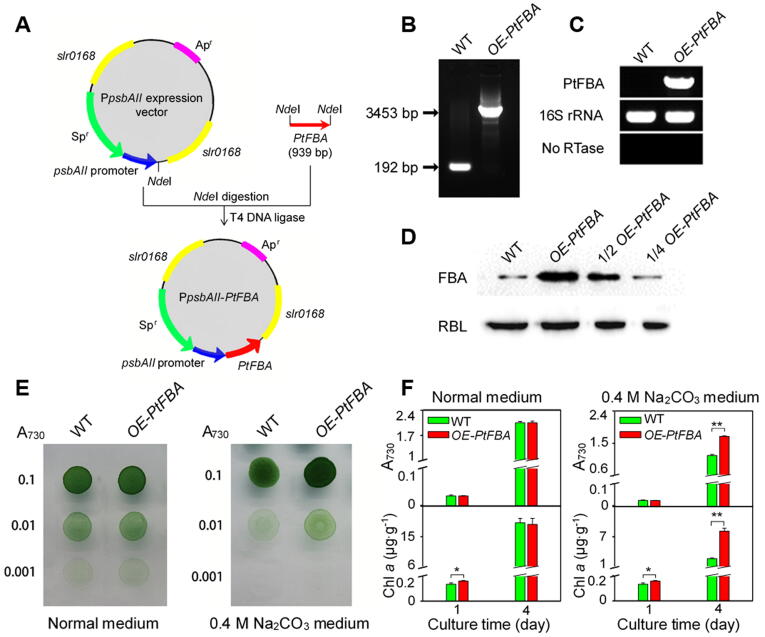
Transgenic analysis of chloroplast-localized PtFBA gene in a model cyanobacterium Synechocystis sp. strain PCC 6803A. Construction of an overexpression vector PpsbAII-PtFBA, to generate the PtFBA overexpression (OE-PtFBA) strain in S. PCC 6803. B. PCR analysis of the OE-PtFBA cells. C. The transcript levels of PtFBA in the wild-type (WT) and OE-PtFBA strains. The transcript level of 16S rRNA in each sample is shown as a control. The absence of contamination of DNA was confirmed by PCR without reverse transcriptase (No RTase) reaction. D. Evaluation of fructose-bisphosphate aldolase (FBA) levels in WT and OE-PtFBA strains by immunoblotting with FBA antibody. Lanes were loaded with 15 μg (for WT and OE-PtFBA), 7.5 ug (for 1/2 OE-PtFBA), 3.75 ug (for 1/4 OE-PtFBA) total proteins and RBL was used as a loading control. E. Growth of WT and OE-PtFBA strains under 0.4 M Na2CO3. Three μl of cell suspensions with densities corresponding to A730 nm values of 0.1 (upper rows), 0.01 (middle rows), and 0.001 (lower rows) were spotted on agar plates with normal medium (on the left) and 0.4 M Na2CO3 medium (on the right), respectively. F. A730 nm values and chlorophyll a (Chl a) contents in WT and OE-PtFBA strains after cultivation in the normal medium and 0.4 M Na2CO3 medium for 1 and 4 days, respectively. Data are presented as mean ± S.D. (n = 3, Student's t test, *, P < 0.05; **, P < 0.01)...